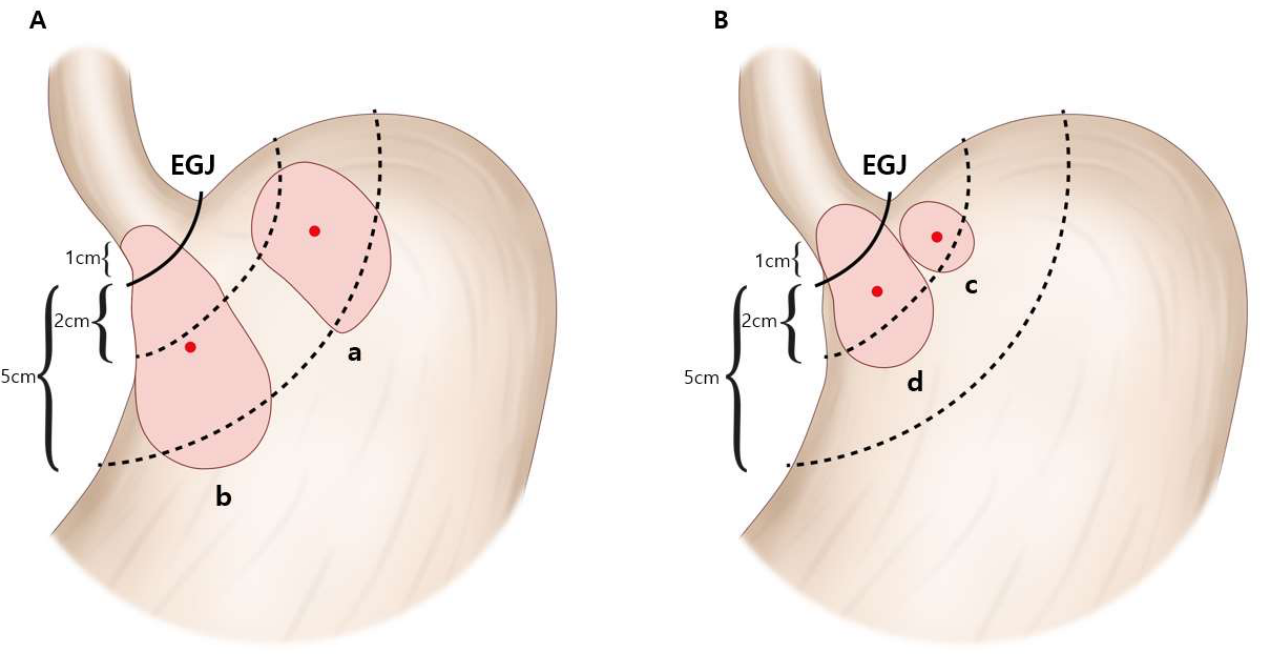
Figure 1. Adenocarcinomas of the cardia and the subcardia. Cardia and subcardia cancers were classified into four categories according to the location of the epicenter (red dots) and invasion of the esophagogastric junction (EGJ). ( A ) When the epicenter is located at the subcardia, the tumor is defined as either subcardia gastric cancer (without EGJ invasion) (a) or AEG (adenocarcinoma of the esophagogastric junction) type III (with EGJ invasion) (b). ( B ) When the epicenter is located at the cardia, the tumor is defined as AEG type II without EGJ invasion (c) or with EGJ invasion (d). AEG: adenocarcinoma of the esophagogastric junction; EGJ: esophagogastric junction.